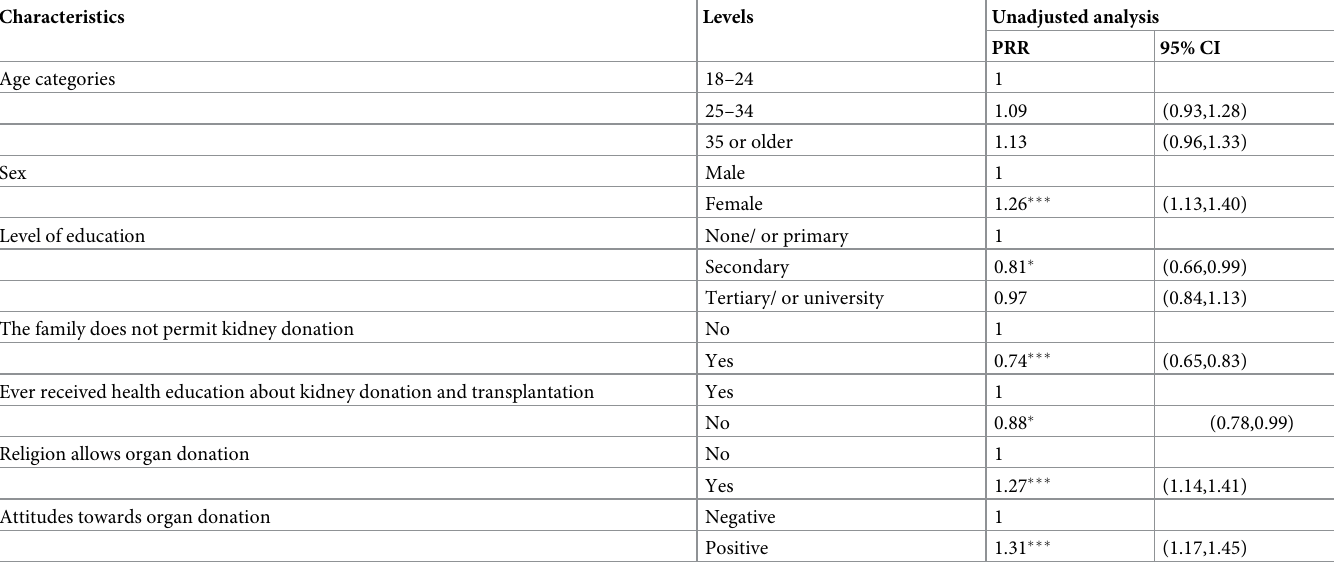
Table 4. Results of unadjusted analysis of factors associated with willingness to donate a kidney for transplant to a patient with ESRD.